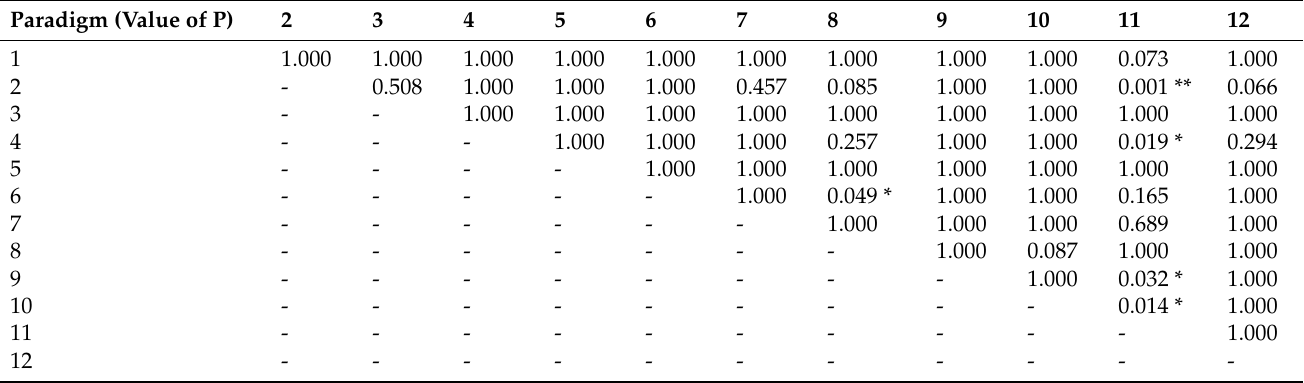
Table A3. Bonferroni Post-Hoc Analysis of Likert Scale of Subjective Preference among Twelve Paradigms.